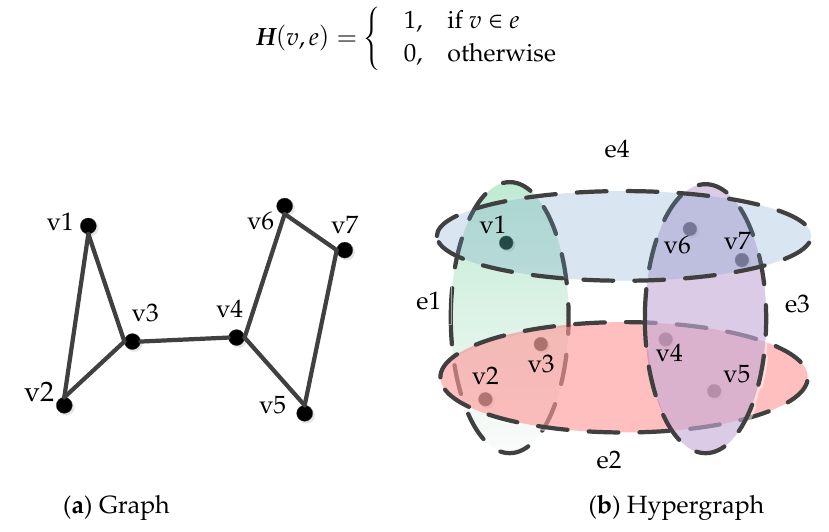
Figure 2. Illustration of a graph and hypergraph.